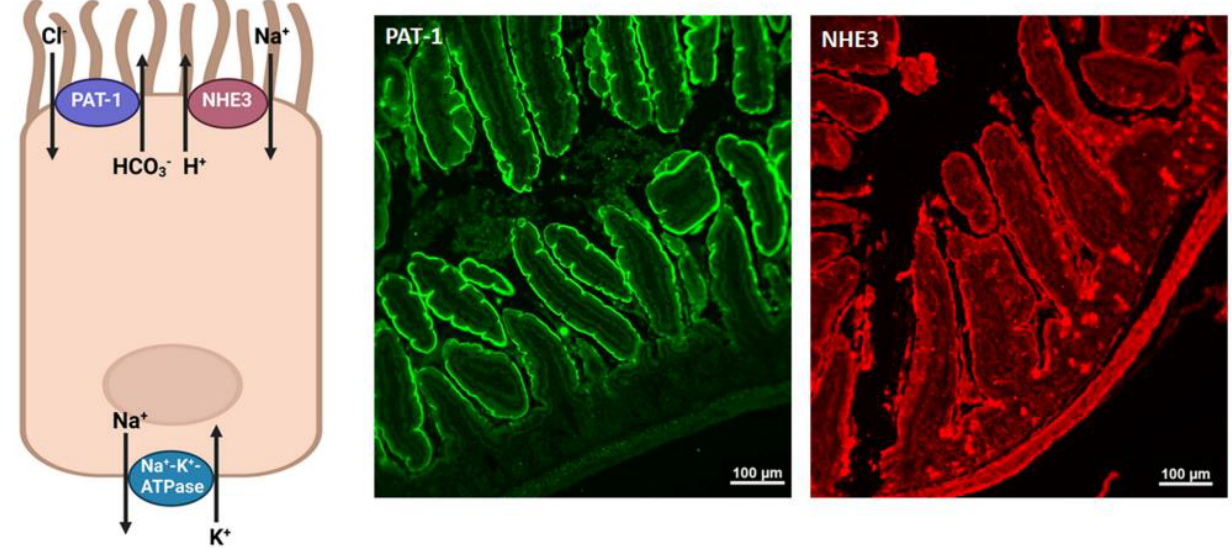
Figure 4. The localization of salt transporters, NHE3 and PAT1, in the small intestine (left, schematic diagram) and by immunofluorescence staining (right). Both NHE3 (red) and PAT-1 (green) show similar expression patterns on the apical membrane of jejunal villi (20× magnification; scale bar 100 μ m). Schematic diagram created with Biorender.